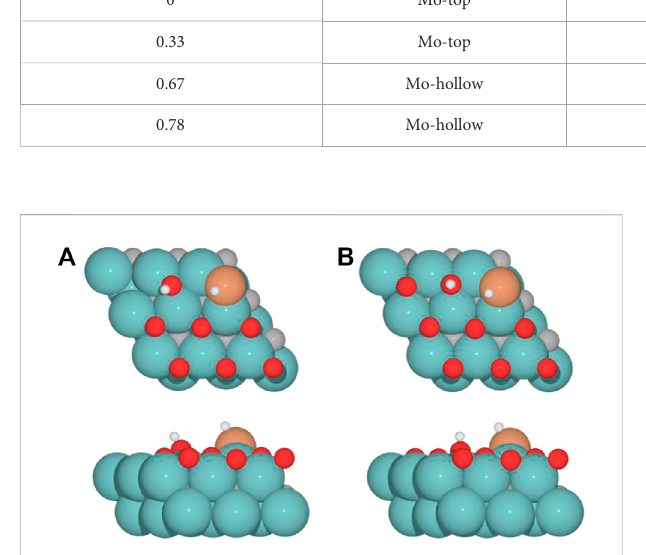
FIGURE 7 Top and side views of new minima were obtained where the H* atom remains at the top of the metal center involved in Fe/Mo 2 C coverage of (A) 0.67 and (B) 0.78 ML for H 2 O* formation.